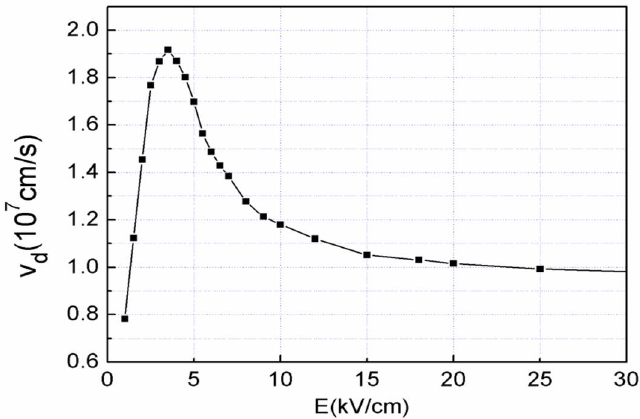
Figure 6. Carrier drift velocity as a function of the bias field.